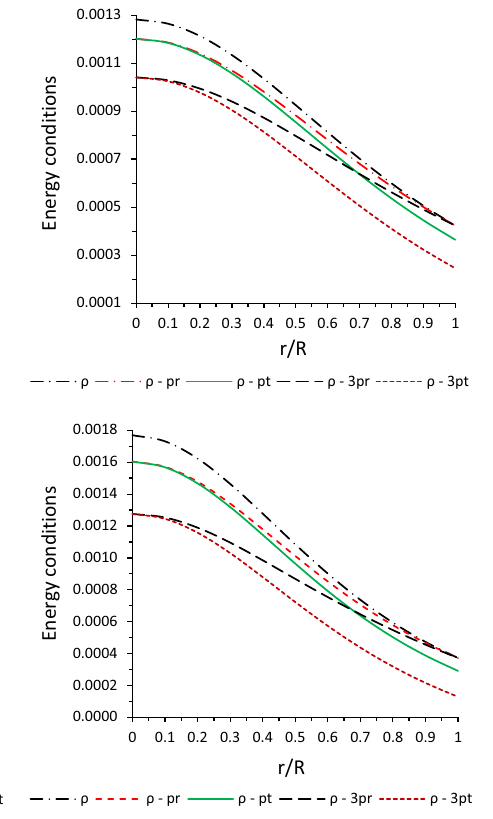
Fig. 6 Behaviour of dominant energy conditions vs. fractional radius r / R forLMCX-4( topleft ),EXO1785-248( topright ),PSRJ1903+327 ( bottom left ) and 4U 1820-30 ( bottom right ). For plotting this fig- ure the numerical values of physical parameters and constants are as follows: (i) a = 0 . 004, b = 0 . 0021, c = 0 . 0107, A = 0 . 4806, B = 1 . 2607, M = 1 . 29 M (cid:7) , and R = 8 . 831 km for LMC X-4, (ii)